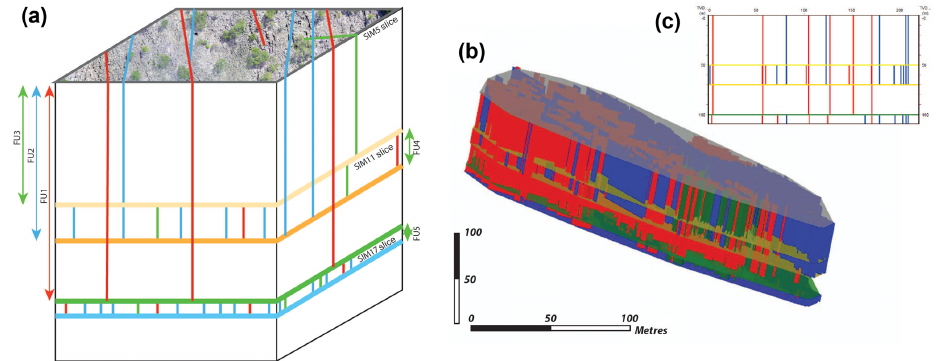
Figure 14. Fracture network extrusion in 3-D. The method consists of identifying the different fracture units (FU) on which the fracture height is supposed to be constant (a) . This method requires one simulation per top fracture unit (SIM slices). (b) A 3-D DFN based on the hypothetical case (a) and realised in GOCAD software. (c) A cross section realised in the centre of the 3-D model in the east–west